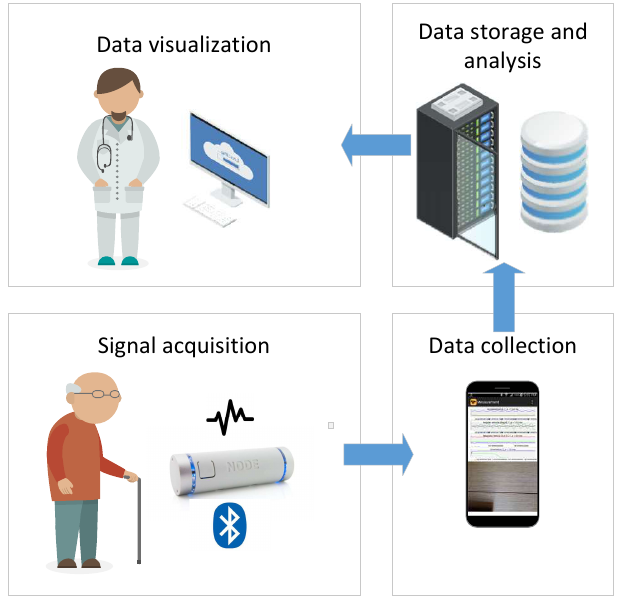
Figure 1. Architecture of Ambient Assisted Living system for remote patient